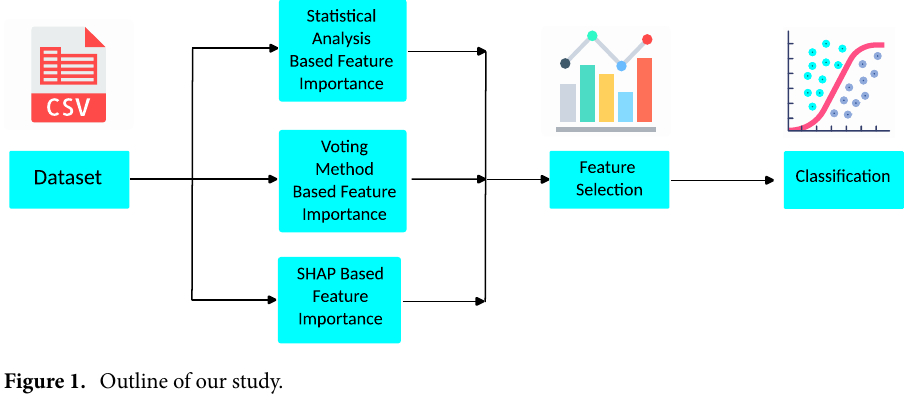
Figure 1. Outline of our